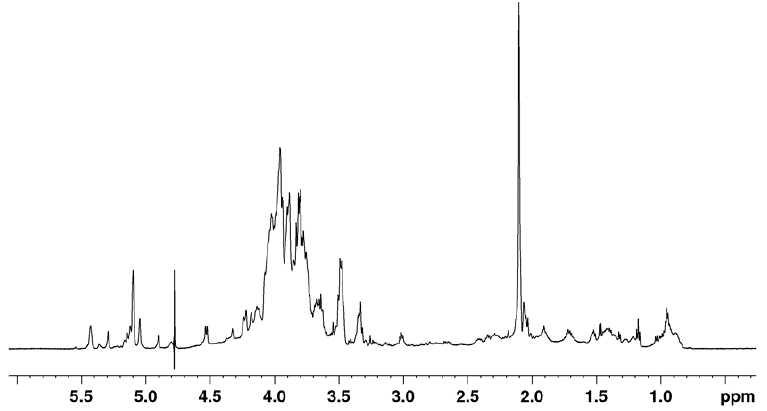
Figure 4. HPLC chromatograph of ( A ) hydrolyzed MOE6-EPS (10 mg/mL) from isolate MOE6 strain; ( B ) glucose control (5 mg/mL); ( C ) glucuronic acid control (5 mg/mL); ( D ) mannose control (5 mg/mL).